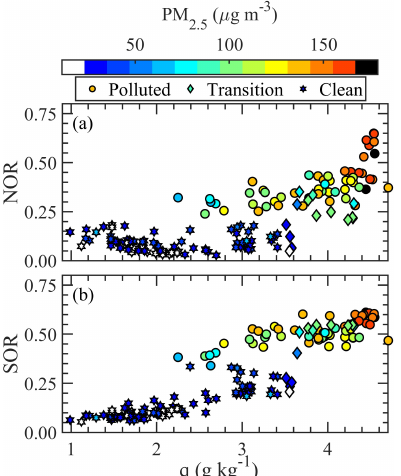
Figure 5. (a) Nitrogen oxidation ratio (NOR) and (b) sulfur oxi- dation ratio (SOR) as a function of q based on hourly Seoul data. Points are colored by PM 2 . 5 with shapes assigned to the three time periods in the study.